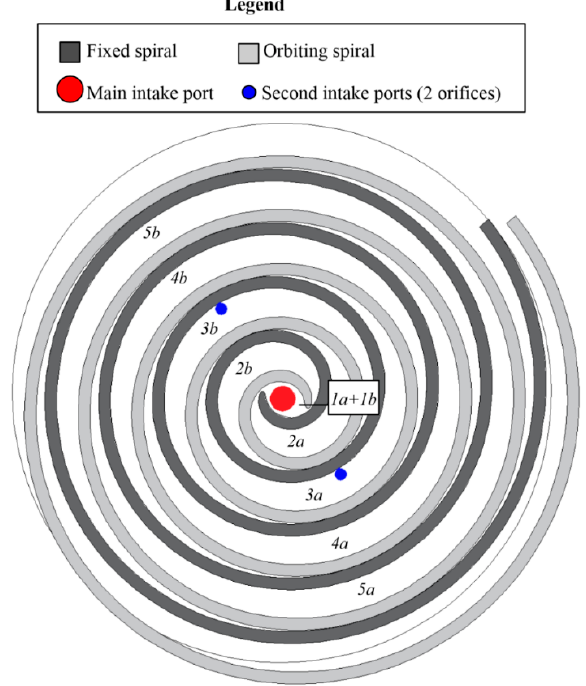
Figure 9. Position of the main and of the second intake DIP ports and definition of the scroll chambers by the interaction of orbiting and fixed spirals.